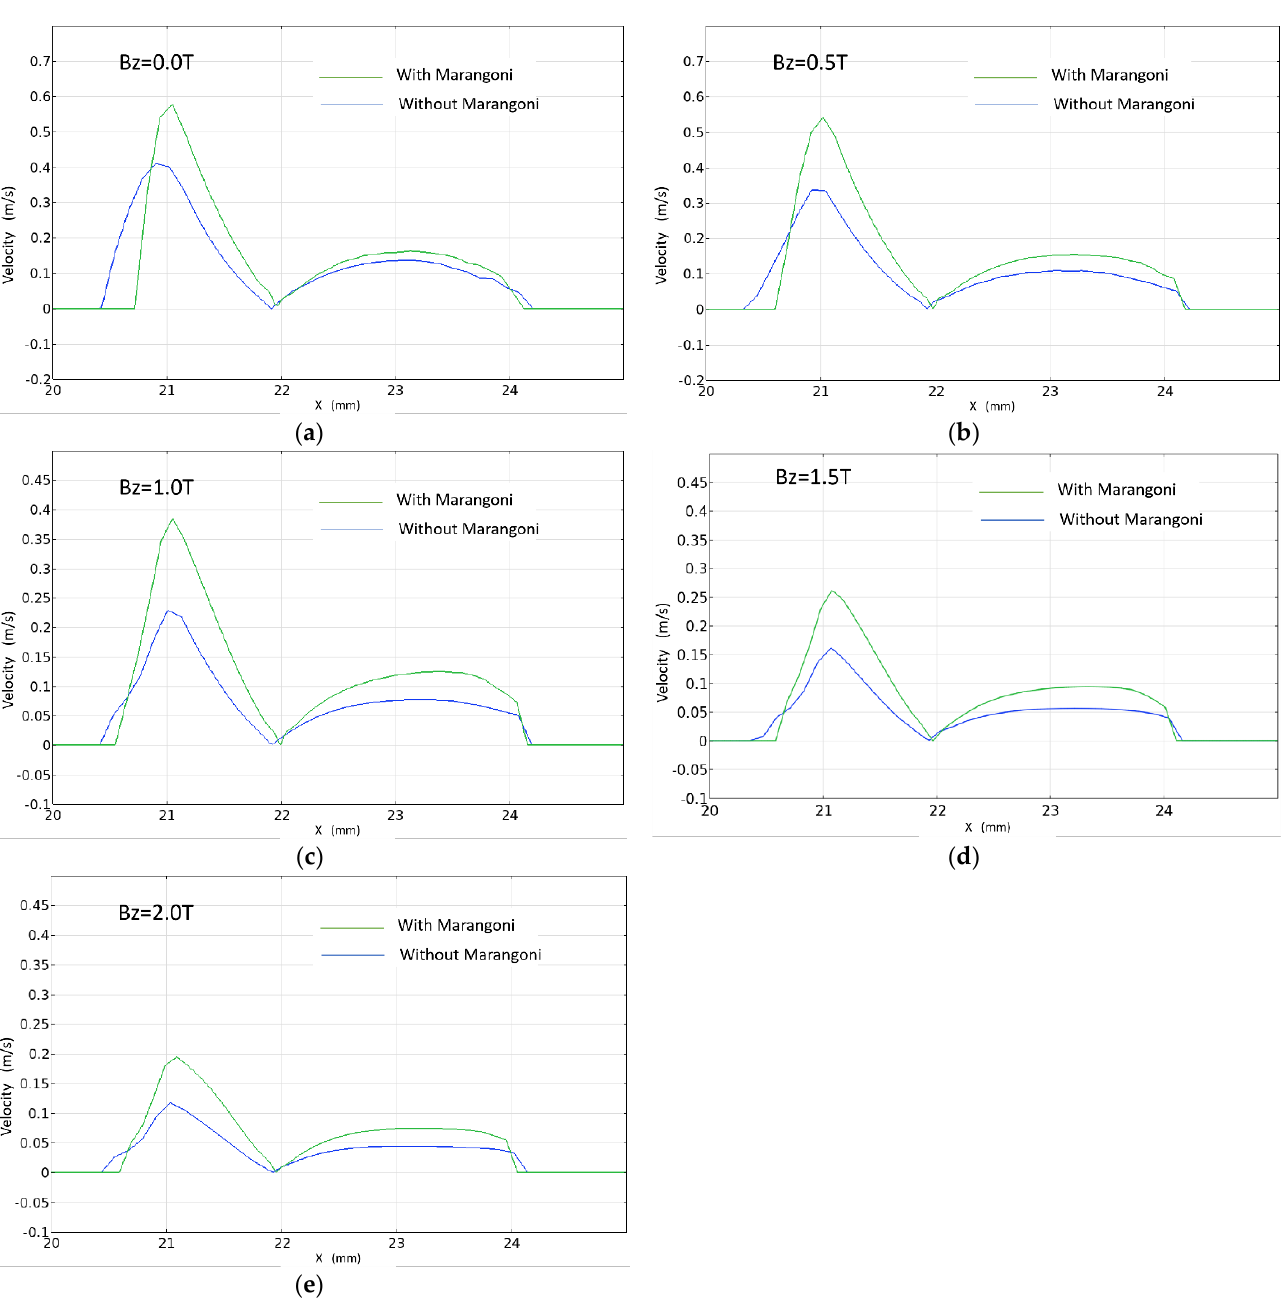
Figure 8. Effect of Marangoni force on the flow field at different magnetic field strengths (t = 4.5 s). ( a ) Bz = 0.0 T; ( b ) Bz = 0.5 T; ( c ) Bz = 1.0 T; ( d ) Bz = 1.5 T; and ( e ) Bz = 2.0 T.